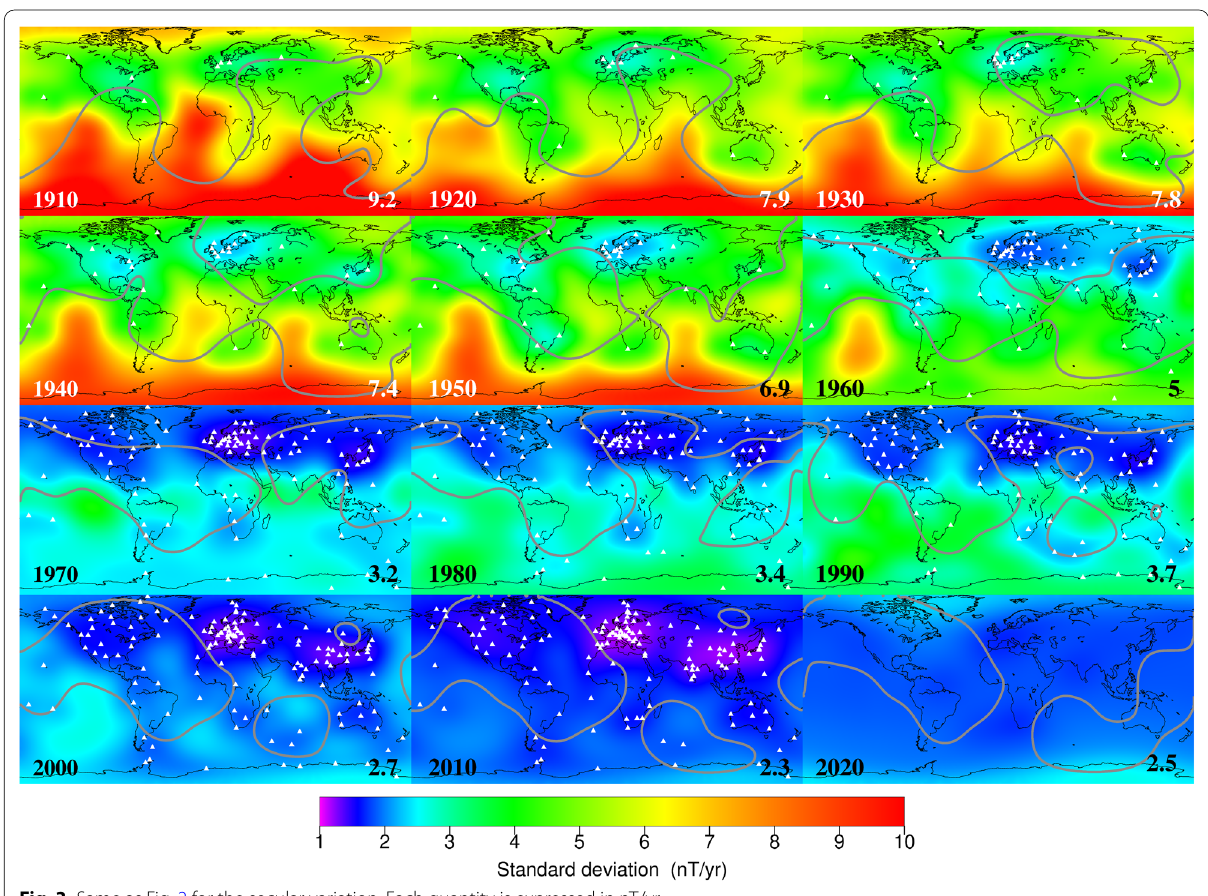
Fig. 3 Same as Fig. 2 for the secular variation. Each quantity is expressed in